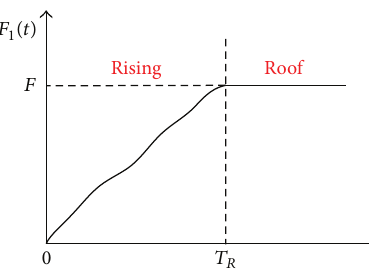
Figure 6: The applied force is composed of rising and roof stages.